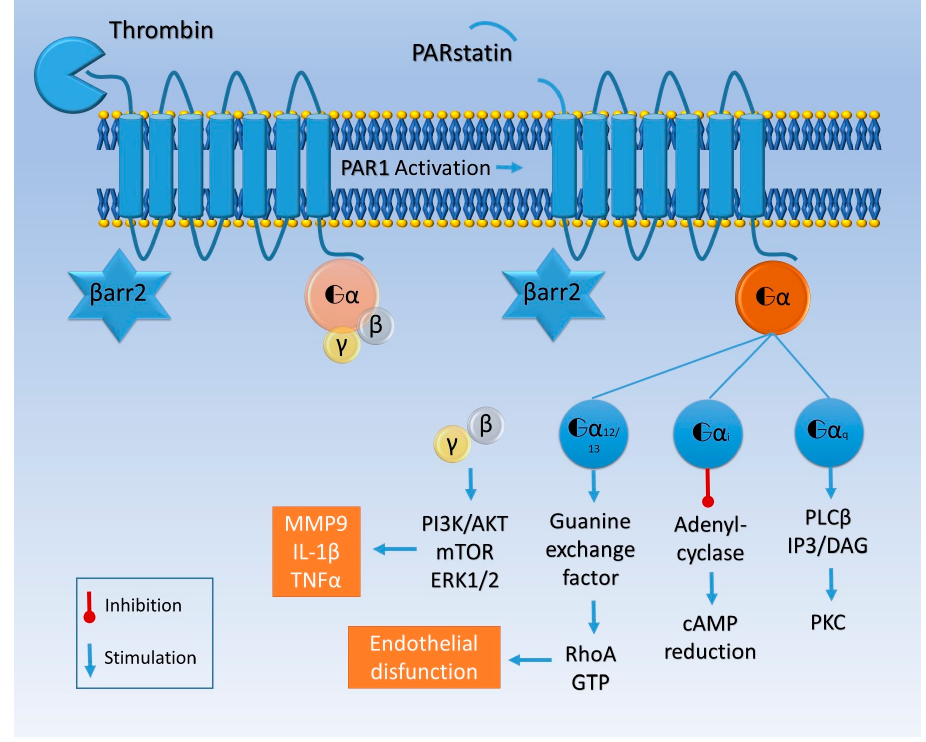
Figure 2. Thrombin cleaves the amino-terminal domain of PAR1 and triggers intracellular signaling. The residual 41 amino acid peptide is called parstatin. PAR1 can be associated with G α q, G α i/o, or G α 12/13 proteins. G α q activates phospholipase C β (PLC β ), which catalyzes the formation of inositol trisphosphate (IP3) and diacylglycerol (DAG), which in turn activates protein kinase C (PKC). G α i blocks adenylyl cyclase and reduces cyclic adenosine monophosphate (cAMP). G α 12/13 is associated with guanine exchange factors and activates RhoA. βγ subunits activate the phosphatidylinositol 3 kinase (PI3K) pathway, leading to the production of MMP9, IL-1 β , and TNF α . This is the “classic” PAR1 activation, and in this scenario β arrestin 2 ( β arr2) remains inactive.